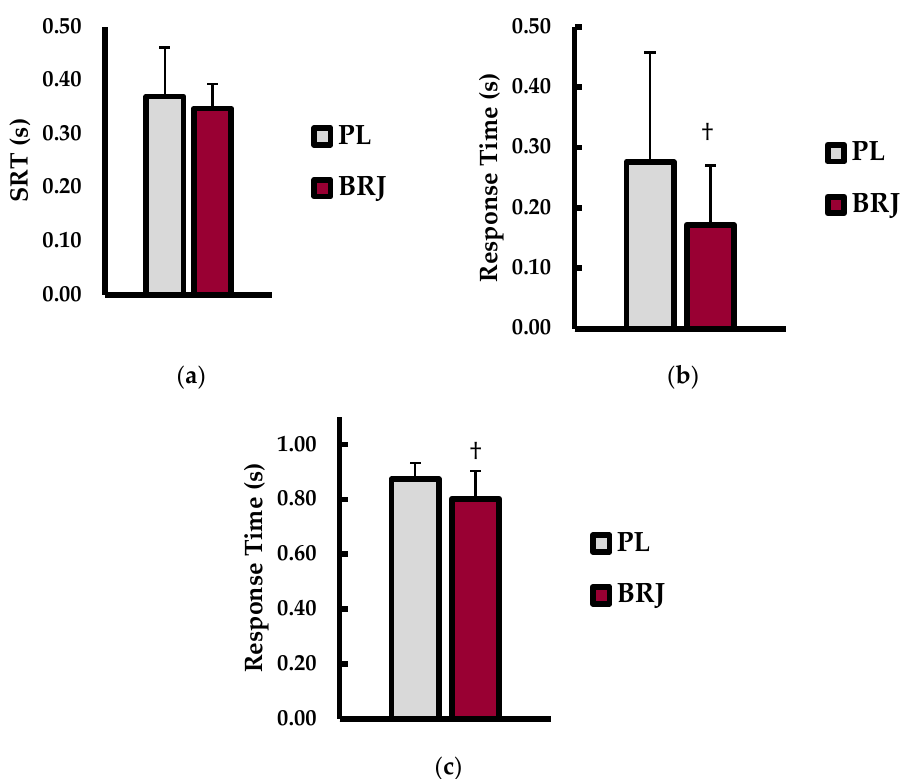
Figure 3. Differences in ( a ) Simple reaction time (s; SRT) ( b ) Get-up and go drill response time (s) and ( c ) Semi-circle drill response time (s) between placebo (PL; grey bars) and beetroot juice (BRJ; dark red bars). Data are presented as mean ± SD. † indicates significantly different from PL ( p < 0.05).